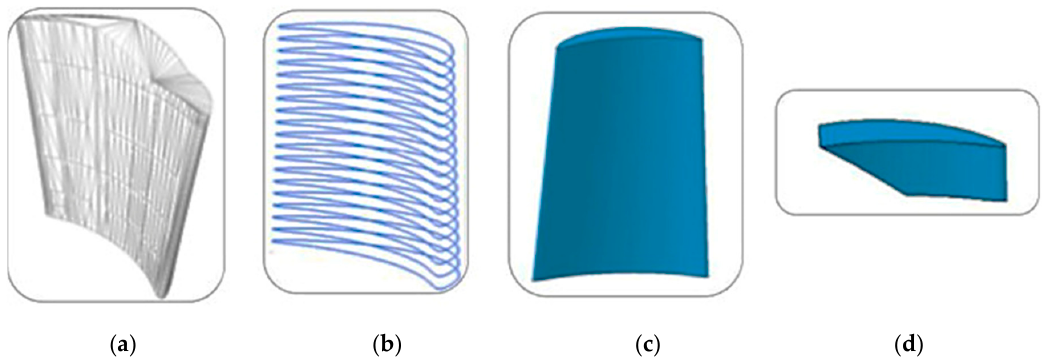
Figure 15. Process for generating a parameterized geometric model required for DED-based defect repair: ( a ) acquire point clouds and generate mesh, ( b ) extract Prominent Cross Section (PCS) from non-defective region and extrapolate missing section, ( c ) reconstruct repaired model in CATIA™, and ( d ) extract Boolean difference between ( a ) and ( c ) to obtain the repair volume [18].